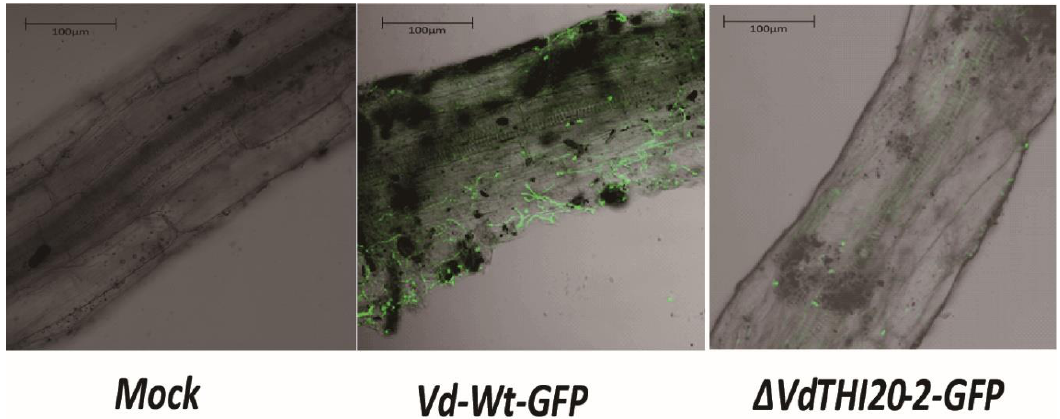
Figure 8. Green fluorescent protein (GFP) fluorescence detection of fungal colonization and root infection in N. benthamiana with the Vd-wt-GFP strain, the ΔVdTHI20-2-GFP mutant strains, and sterile water (mock) at 3 dpi.